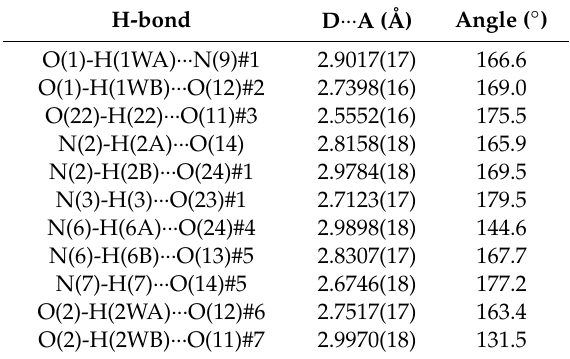
[Cd(HEDTA)(H 2 O)] · H 2 O ( 1 ). The distances were measured between the heavy atoms.